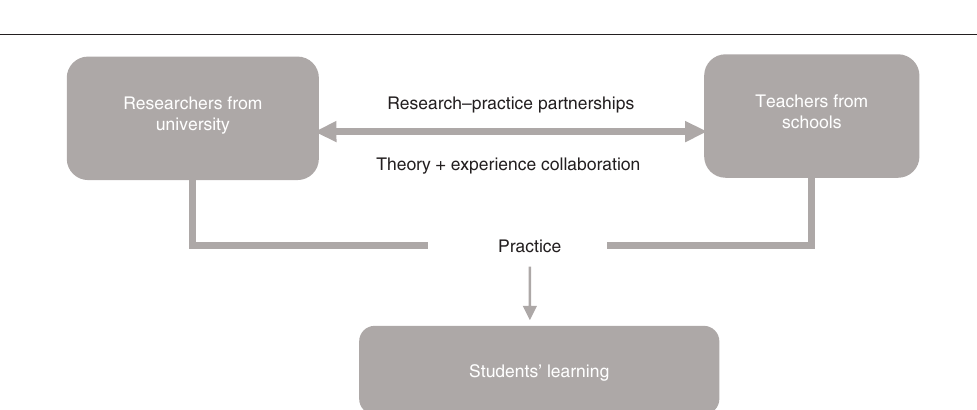
Figure 2: Modes of interaction between university and teachers doing research: horizontal model within research–practice partnerships Source : Adapted from Chow et al.